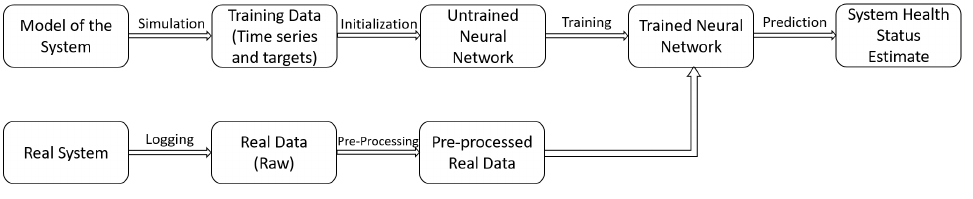
Figure 1. Schematization of the proposed